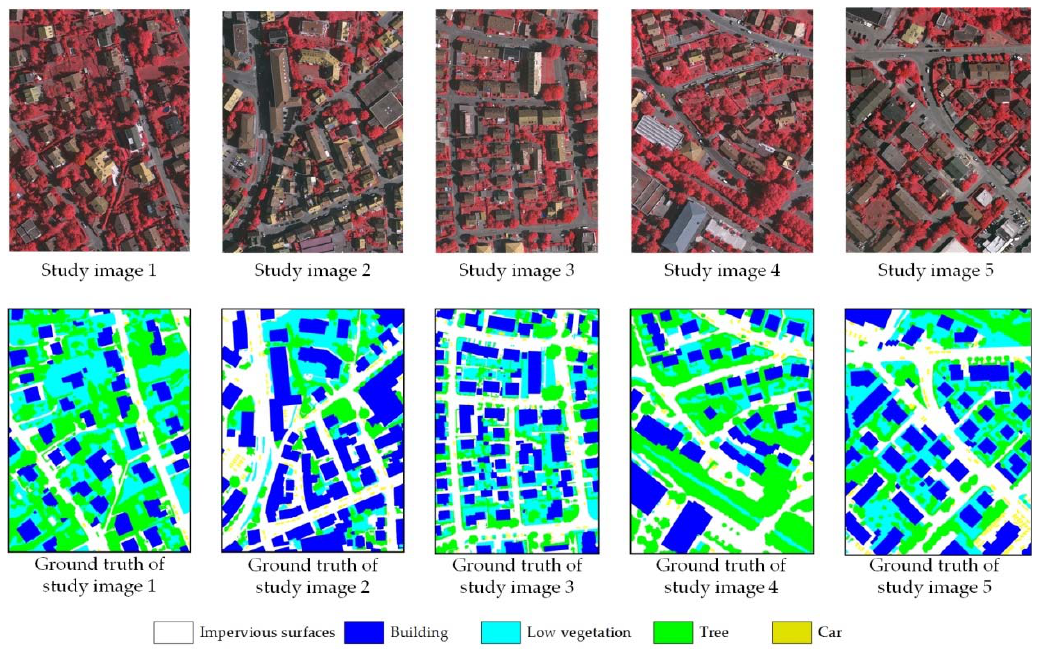
Figure 4. The study images and their corresponding ground truth from the Vaihingen dataset.